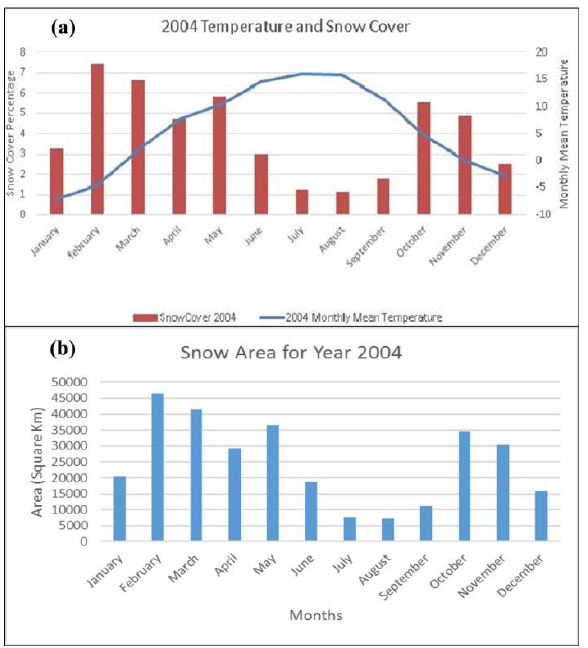
Figure 4: (a) Snow Area for year 2004 and (b) Comparison of Temperature and Snow Cover for year 2004 Snow mass balance is calculated by using snow depth and snow density from ERA Interim data. These parameters are multiplied with area of snow to find snow mass balance.